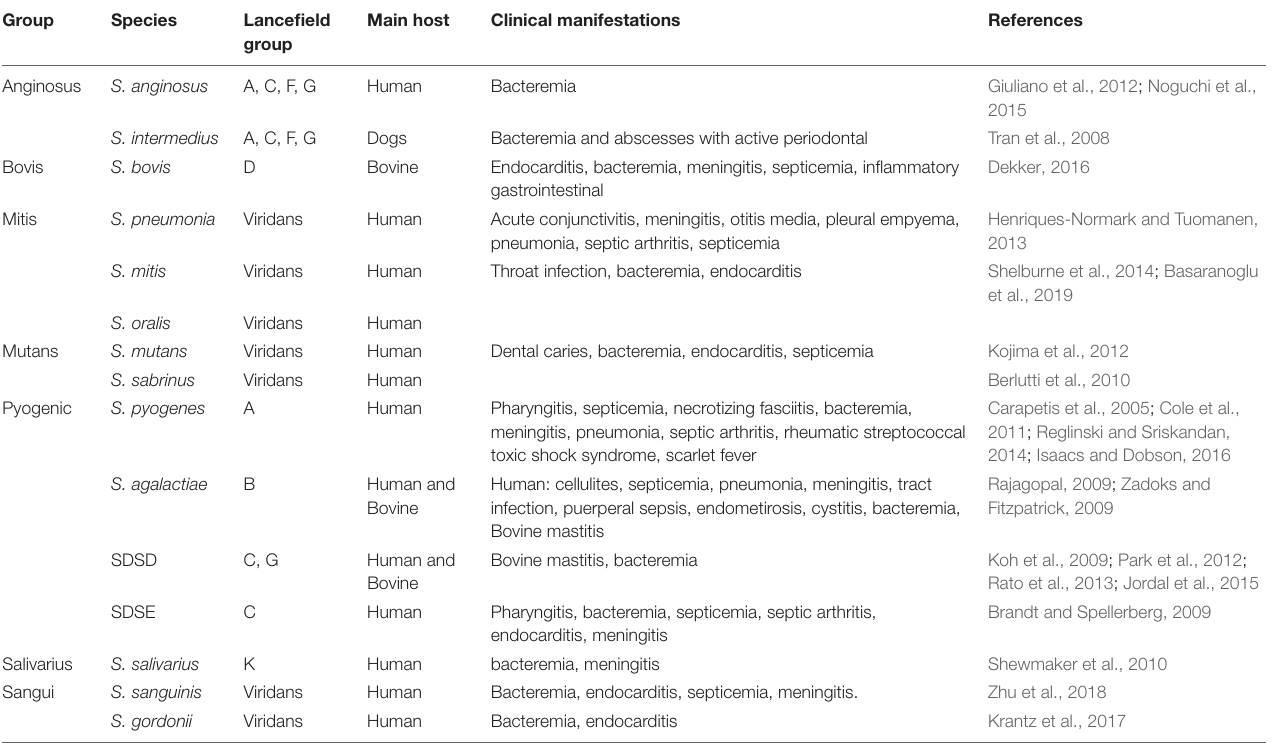
TABLE 1 | S treptococcus species of clinical and veterinary